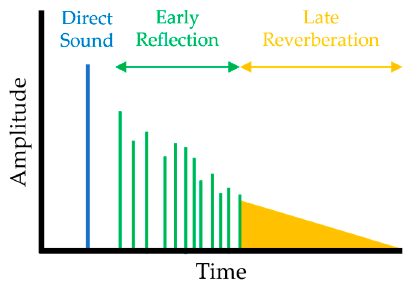
Figure 1. Amplitude of each component over time (direct sound, ER,